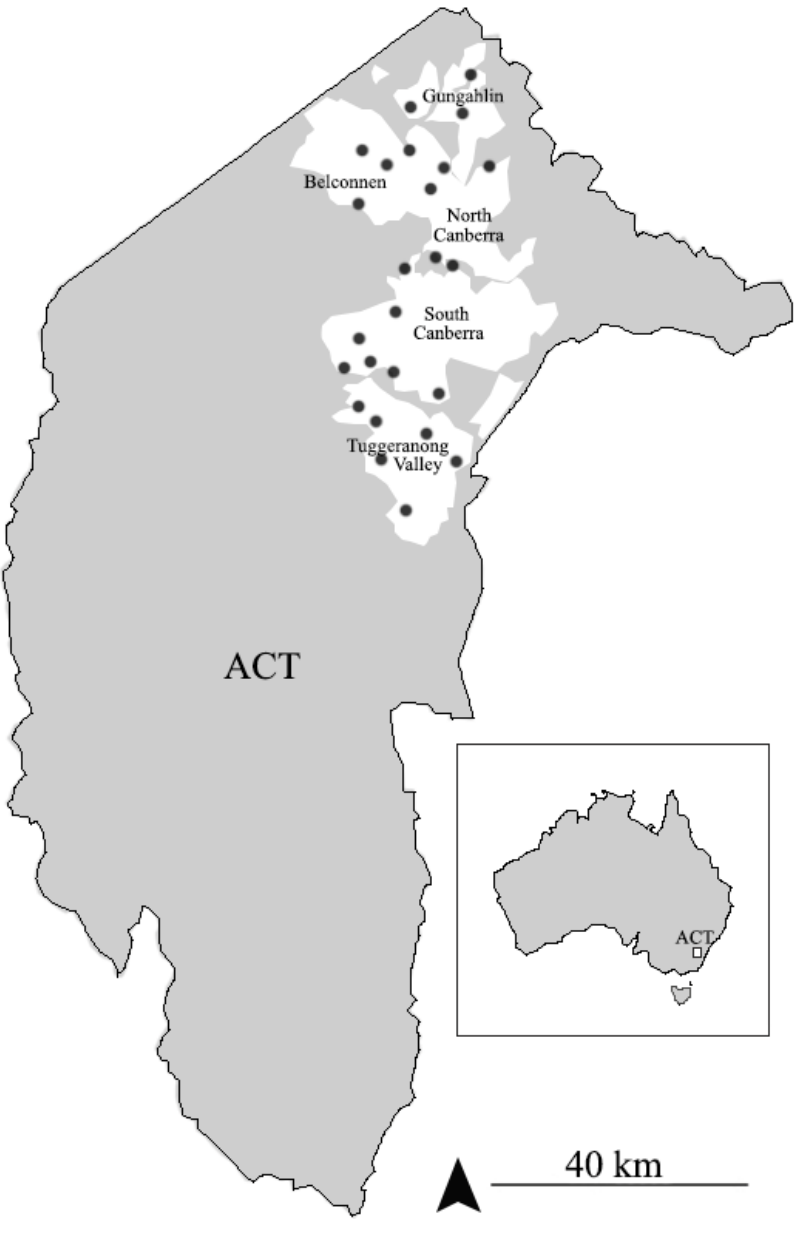
Figure 1. Nest collecting sites within ACT: urban area and Canberra suburbs highlighted with white and the nest collected sites are marked with black dots. (Total sites visited: 95.)